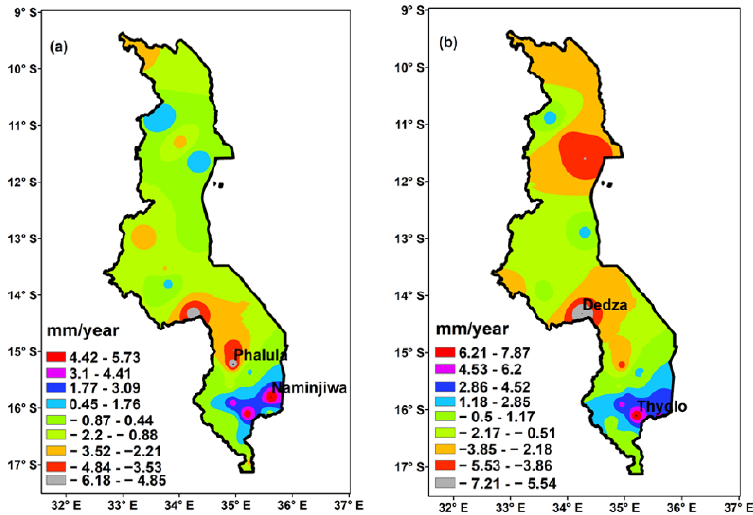
Figure 8. Sen’s slope for ( a ) annual precipitation and ( b ) seasonal precipitation through the period of 1979–2015 over Malawi. Atmosphere 2020 , 11 , x FOR PEER REVIEW